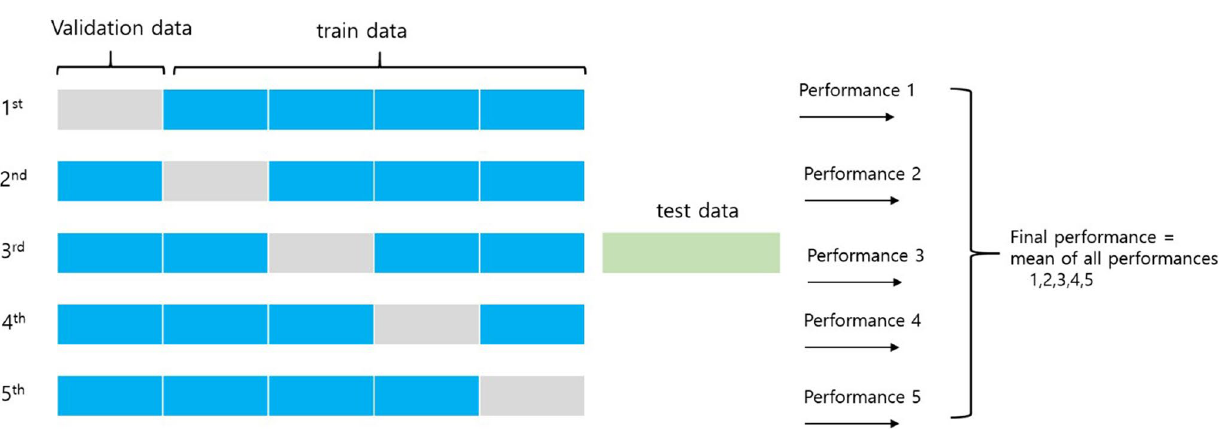
Figure 9. 5-folds cross validation. Trying 5 iterations and getting final results with mean of all